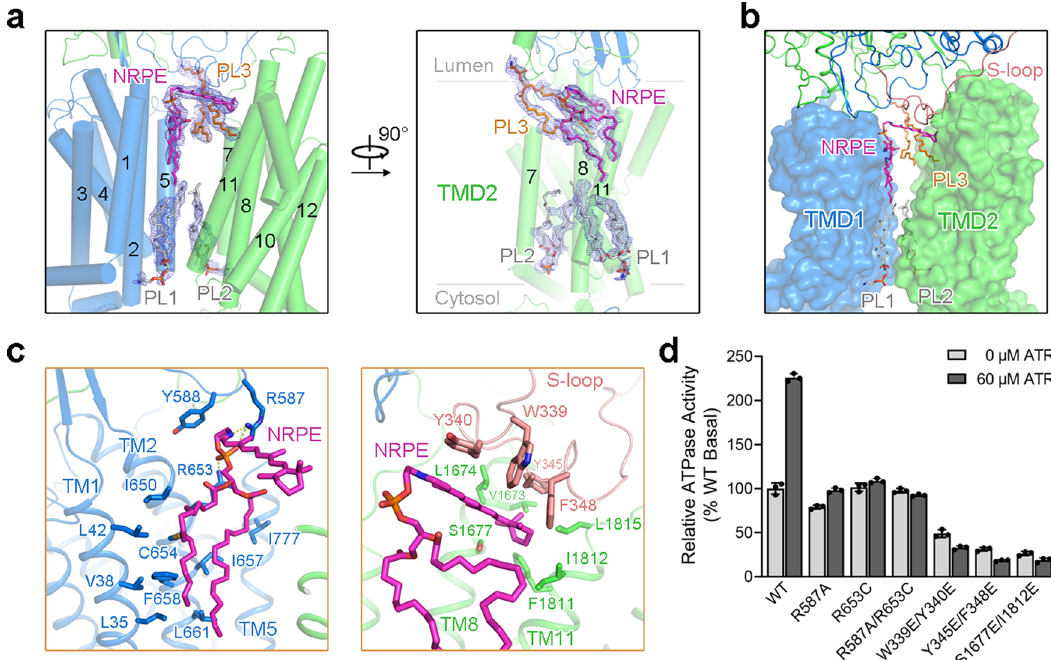
Fig. 3 NRPE substrate binding site. a Electron density maps of NRPE and phospholipids in the TMDs of NRPE-bound ABCA4 structure. The density maps, shown as blue mesh, are contoured at 4 σ . TMD1 and TMD2 are colored marine and green, respectively. The phospholipids in the cytoplasmic lea fl et are shown as gray sticks. The NRPE and phospholipid in the luminal lea fl et are colored magenta and orange, respectively. b Exposure of NRPE and phospholipids to the lipid bilayer. The S-loop from ECD1, in close proximity to the transmembrane region and involved in NRPE coordination, is highlighted in light pink. c Close-up views of the NRPE-binding site. Residues mediating the interactions are shown as sticks. Potential polar interactions are represented by yellow dashed lines. d Functional veri fi cation of key residues involved in NRPE coordination evaluated by the ATR-stimulated ATPase activity of ABCA4. The ATPase activity was normalized relative to the basal ATPase activity of the WT ABCA4. Each data point is the average of three independent experiments, and error bars represent the s.d. Source data for graph d are provided as a Source Data fi